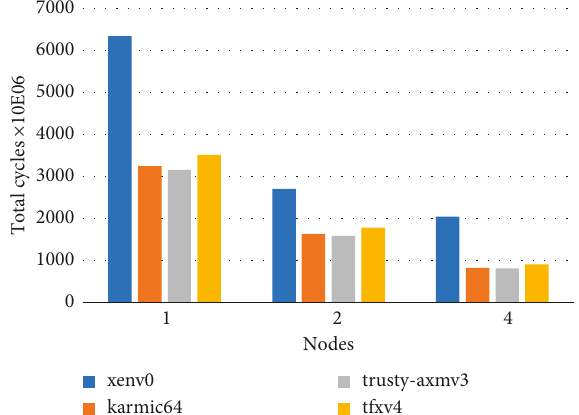
Figure 12: Total number of cycles in the COTSon framework when using the matrix multiplication benchmark with 512 as the matrix size and 32KiB as the cache size. We varied the number of nodes of the distributed system and the Linux distribution (“xenv0” “karmic64” Ubuntu 9.10, “trusty-axmv3” Ubuntu 14.04, and “tfxv4” Ubuntu 10.10). The DSE allows us to determine that the four Linux (cid:31) (cid:31) (cid:31) distributions permit to obtain a good scalability when we increase the number of nodes. However, the “xenv0” confirms the worst performance in terms of executed cycles due to the huge number of kernel cycles shown in Figure 11.